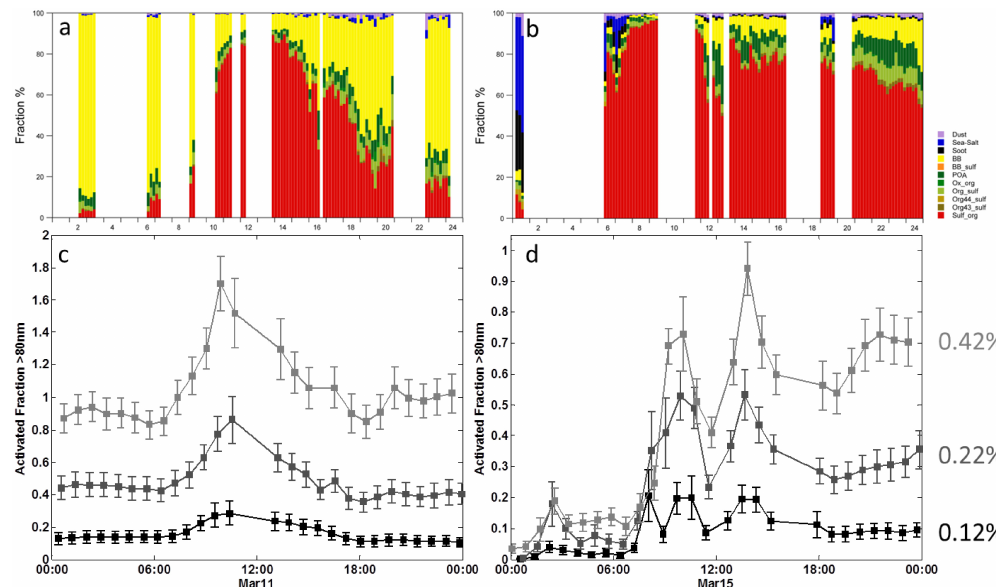
Fig. 6. Time evolution of composition throughout 11 March (a) and 15 March (b) ; Activated fraction of particles greater than 80nm as a function of measured CCN supersaturation and time on 11 March (c) and 15 March (d) . Note clusters and colors are the same for both days.